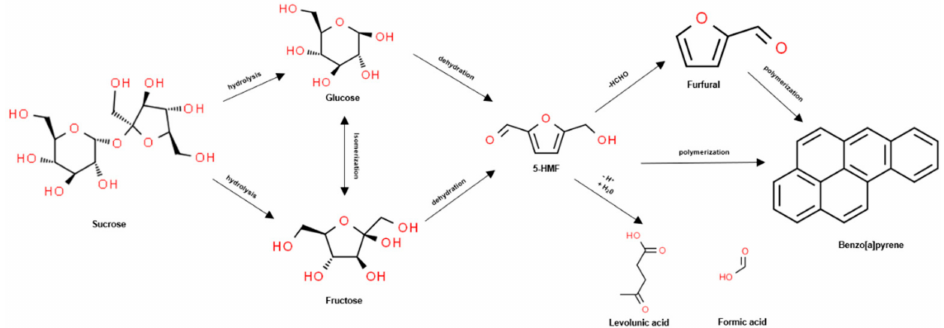
Figure 4. The benzo[ a ]pyrene (BAP) production process in black ginseng; 5-HMF: